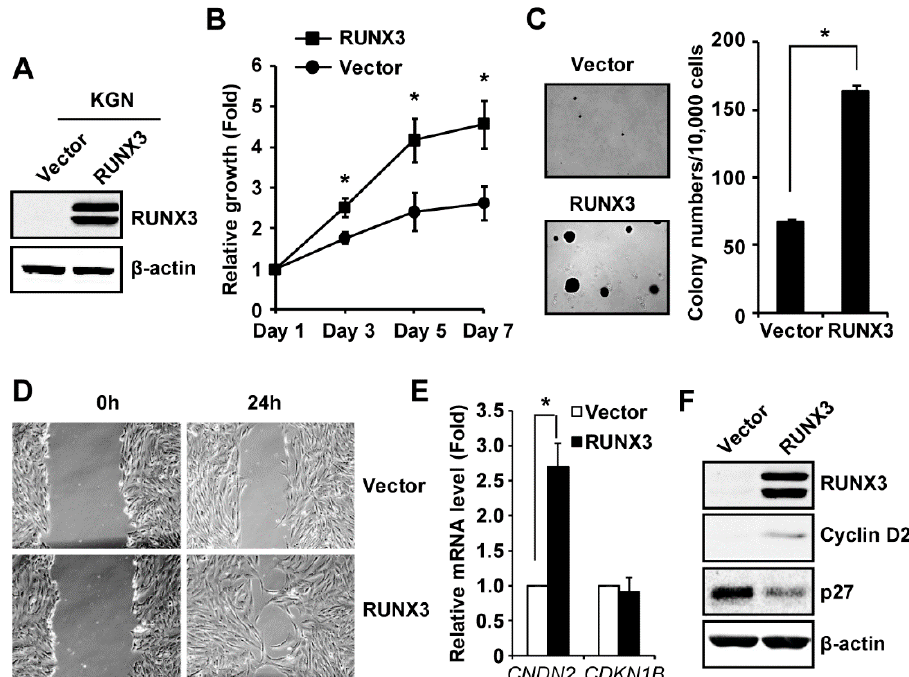
Figure 2. RUNX3 promotes the tumorigenic phenotypes of KGN cell in vitro. ( A ) Ectopic expression of RUNX3 in KGN cells was examined by immunoblotting. β -actin was used as the loading control. ( B ) Cell growth was determined by the neutral red uptake assay and expressed as the fold change relative to day 1. ( C ) Anchorage-independent growth was examined by the soft agar assay and the number of colonies formed by KGN / Vector and KGN / RUNX3 cells were counted. ( D ) Cell motility was determined by the scratch assay. Images were captured under the phase contrast microscope at 100 × magnification. ( E ) The mRNA level of CCND2 (cyclin D) and CDK1B (p27) was measured by quantitative reverse transcription-PCR (qRT-PCR) and expressed as the fold change relative to the vector-only control cells. ( F ) Cyclin D2 and p27 Kip1 protein levels were examined by immunoblotting. β -actin was used as the loading control. Data in ( B , C , E ) are shown as mean ± SE of three independent experiments. * Significantly di ff erent ( p < 0.05). Results in ( D ) and ( F ) are representative of three independent